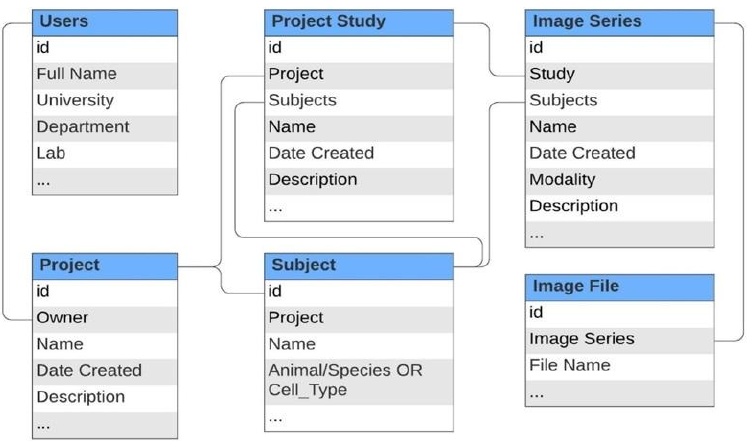
Figure 3. Simplified database schema of the application.